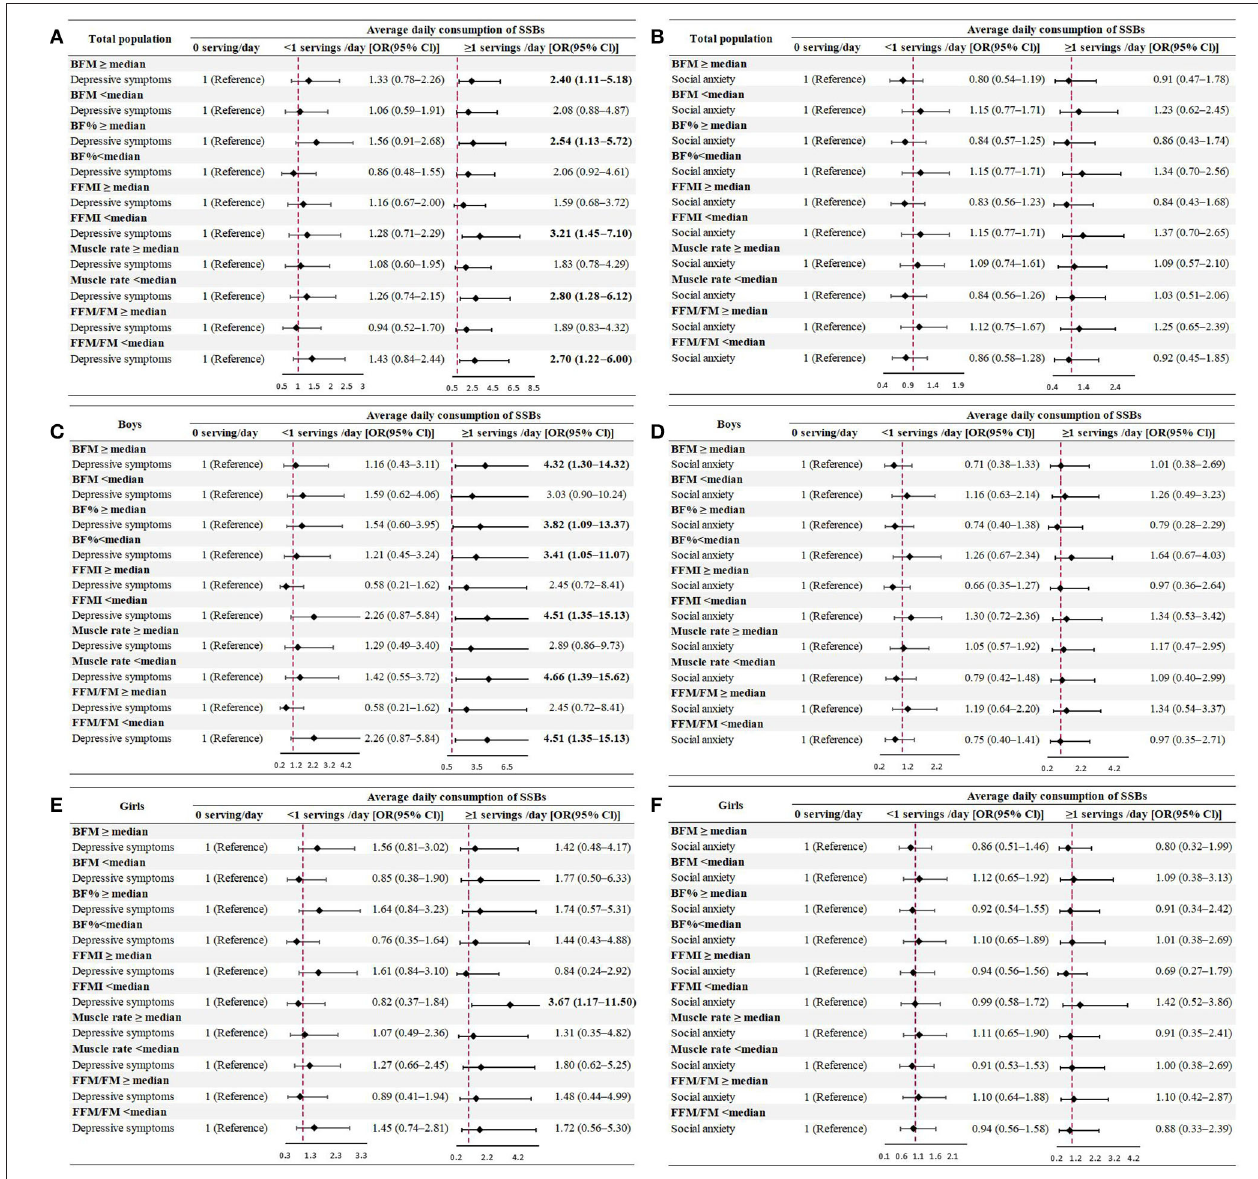
FIGURE 3 | Multivariate odds ratios (OR) and 95% confidence intervals (CI) of SSB consumption for depression ( A,C,E ) and social anxiety ( B,D,F ) symptoms among the total population and each sex group, stratified by body composition (model was adjusted for age, sex, parental educational attainment, maternal smoking status, single-child status, BMI, income, fruit consumption, physical activity, screen time, and the frequency of fried food